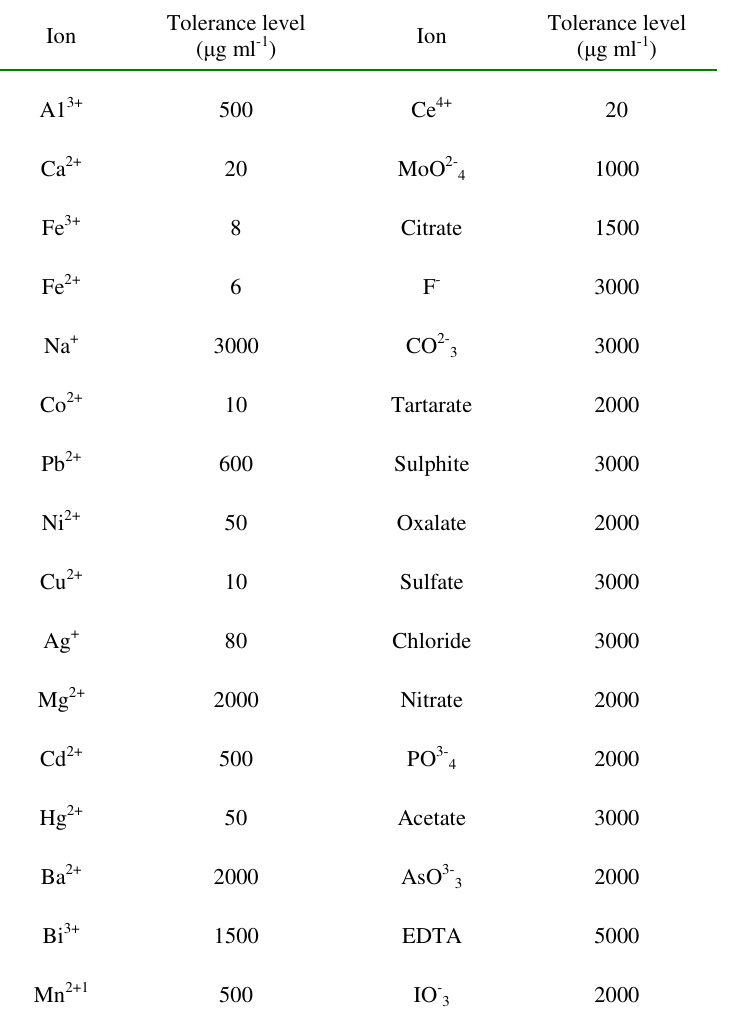
Table 2 . Tolerance of non-target species on the determination of 1 ppm of